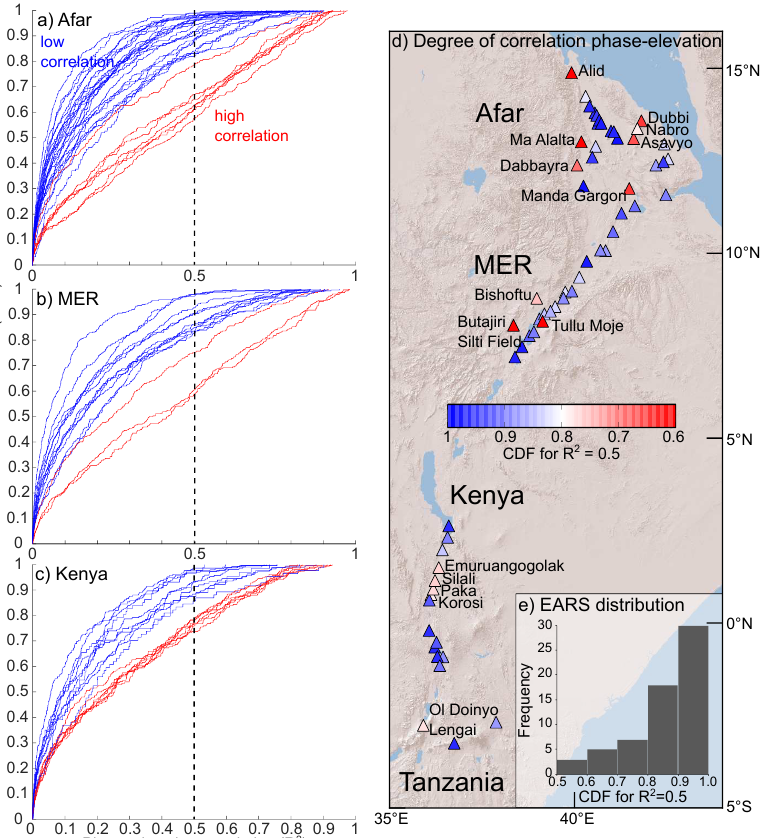
Figure 2. Cumulative Distribution Function (CDF) of the phase-elevation correlation values ( R 2 ) recorded for each volcano at different location along the rift: ( a ) Afar, ( b ) Main Ethiopia Rift, and ( c ) Kenya-Tanzania. Blue lines indicate volcanoes with low phase-elevation corre- lation (CDF(0.5) > 0.8) and red lines indicate volcanoes with high phase-elevation correlation (CDF(0.5) < 0.8), ( d ) map showing the degree of phase-elevation correlation through the value CDF(0.5) for all the volcanoes processed. All volcanoes showed with red triangles were corrected using phase-elevation correlation, ( e ) distribution of the phase-elevation correlation along the